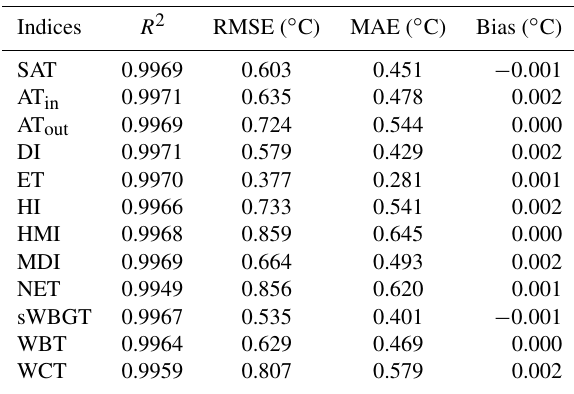
Figure 3. Overall prediction accuracies of the 12 human thermal indices over the mainland of China during 2003–2020. (a) R 2 , (b) MAE, (c) RMSE, and (d) bias. Table 3. Overall prediction accuracies of the 12 human thermal in- dices over the mainland of China during